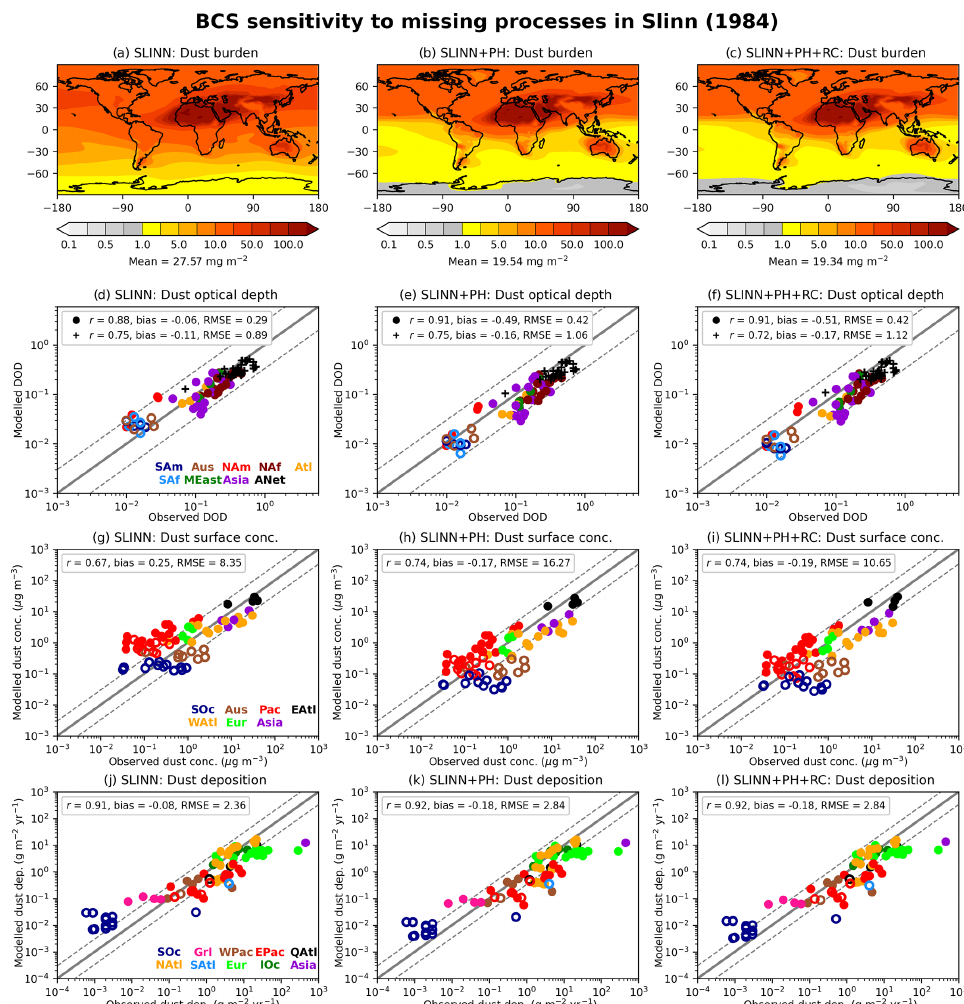
Figure 8. The same as Fig. 7 but for SLINN, SLINN + PH, and SLINN + PH + RC simulations and used to answer KQ2, the impact of missing processes in the Slinn (1984) BCS